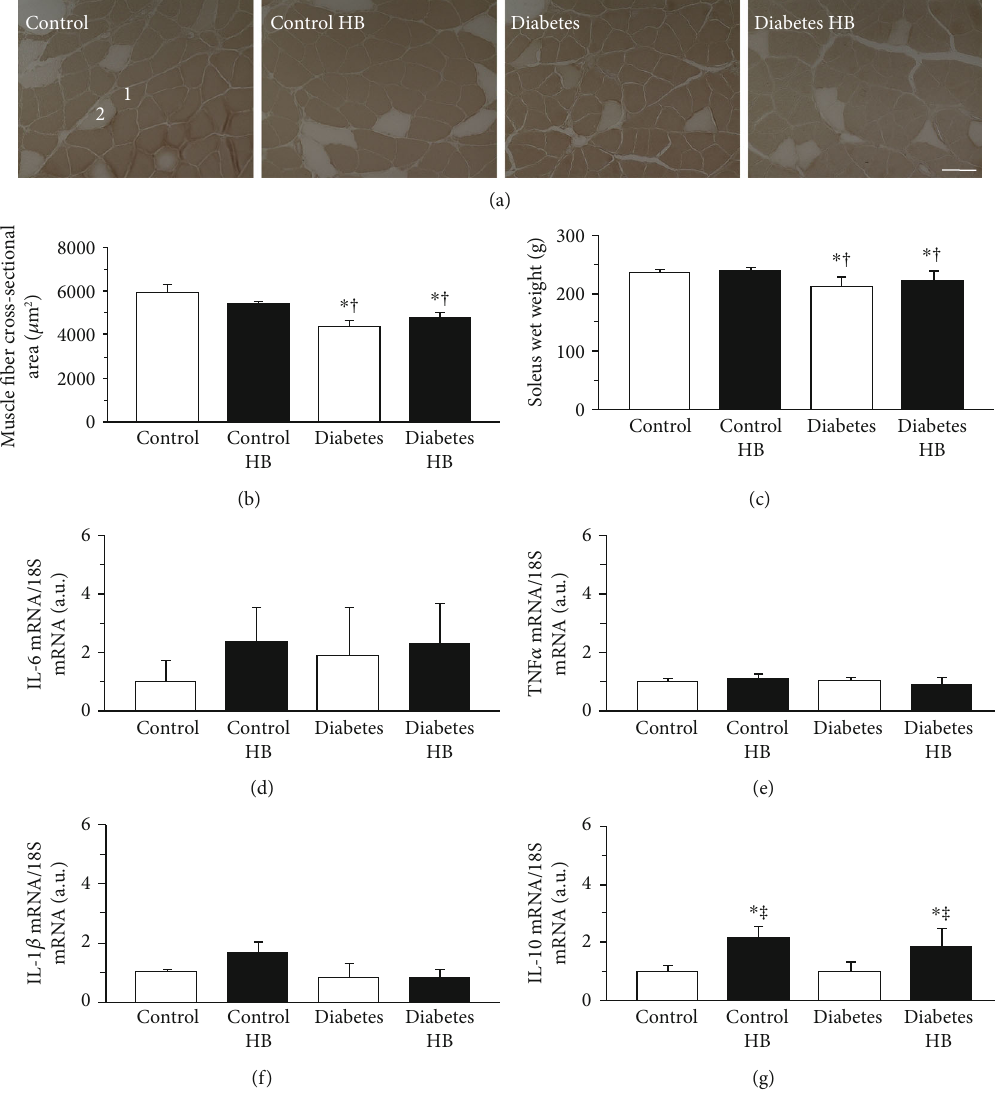
Figure 4: Muscle fi ber cross-sectional area, wet weight, and cytokine expression in the soleus muscle. Representative sections of the soleus muscle stained for ATPase activity (a), type I fi ber cross-sectional area (b), wet weight (c), expression levels of IL-6 mRNA (d), TNF α mRNA (e), IL-1 β mRNA (f), and IL-10 mRNA (g). Control: nontreated control group; Control HB: control treated with the hyperbaric normoxia group; Diabetes: nontreated diabetes group; Diabetes HB: diabetes treated with the hyperbaric normoxia group; 1: type I fi ber; 2: type IIA fi ber. Bar = 100 μ m . Values are means ± standard deviation . IL-6, TNF α , IL-1 β , and IL-10 mRNA expression levels were calculated as fold changes relative to the Control group. ∗ , † , ‡ Signi fi cantly di ff erent from the Control, Control HB, and Diabetes groups, p < 0 : 05 ,